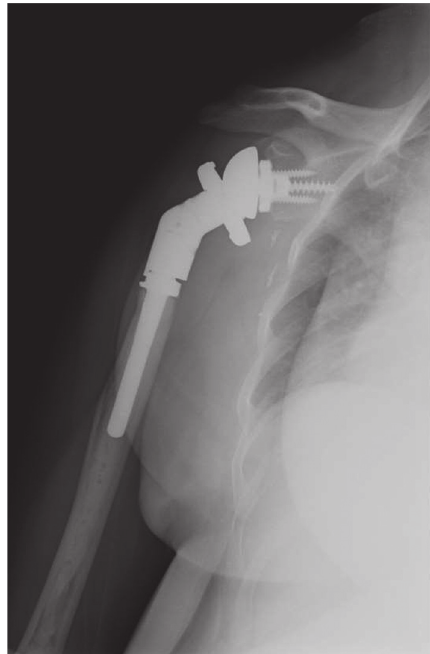
Figure 3: Reverse shoulder megaprosthesis implanted in our institution after massive bone resection due to resection of a malignant bone